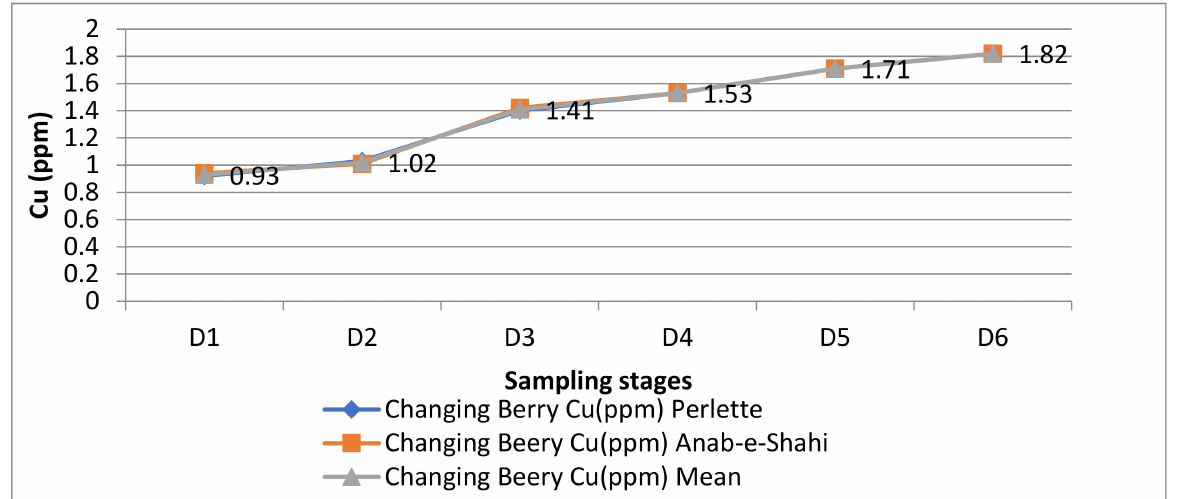
Figure 7. Change of copper (ppm) during the development of berries in grapes, cv. Perlette and